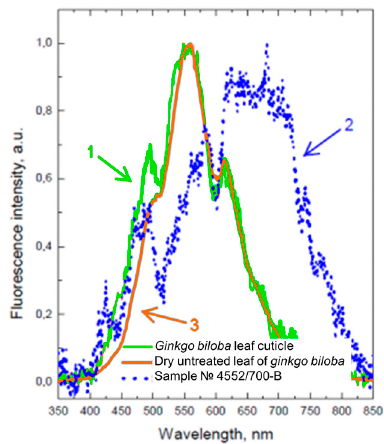
Figure 3. Laser fluorescence spectra of (1) Ginkgo biloba leaf cuticle, (2) Phylladoderma ( Aequistomia ) annulata cuticle (sample No 4552/700-B), and (3) dry untreated leaf of Ginkgo biloba .